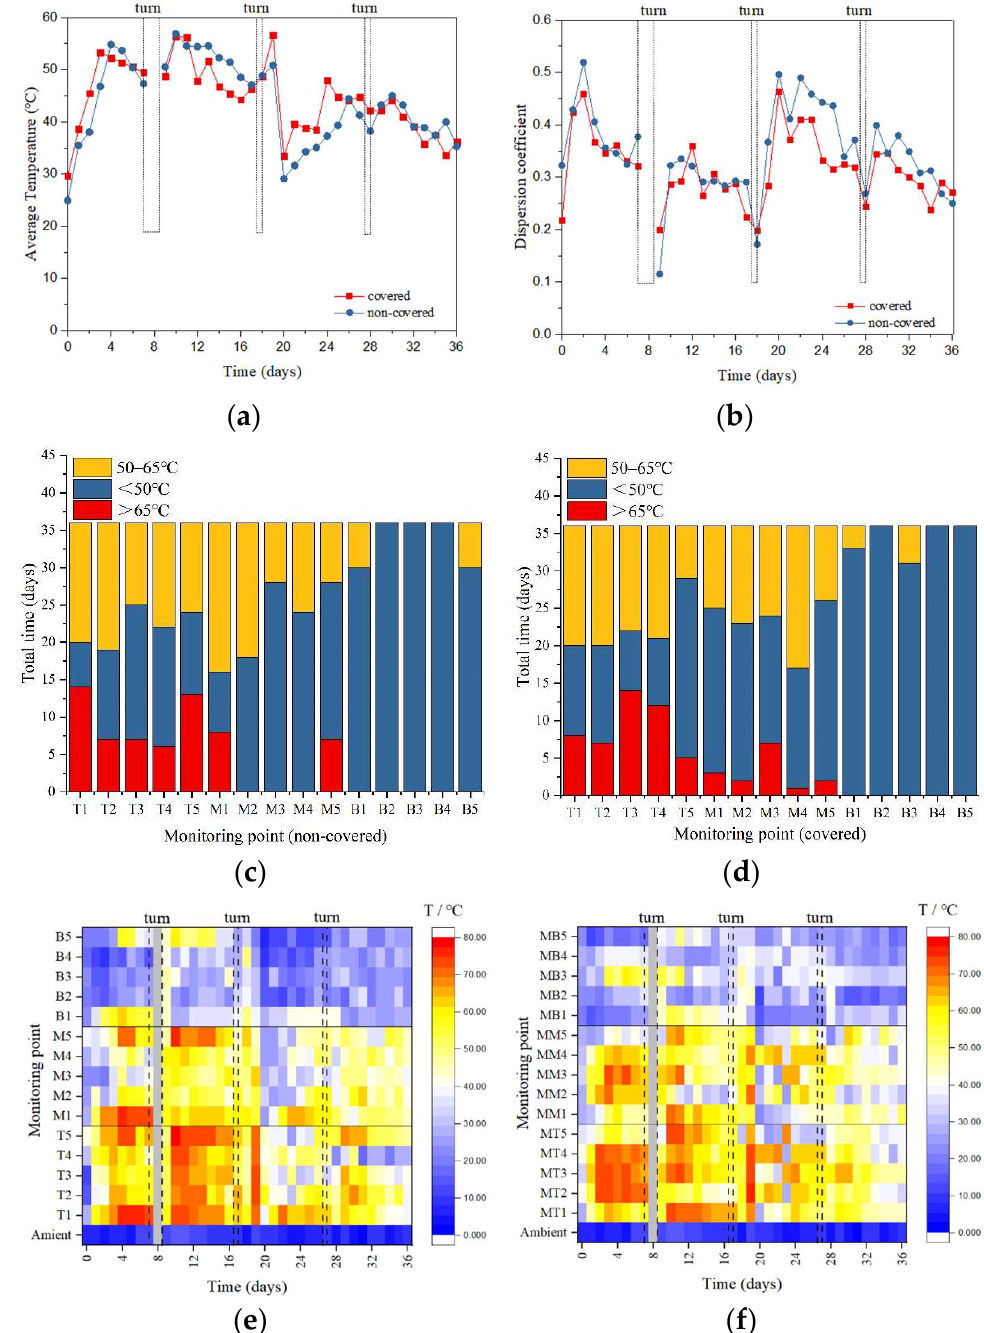
Figure 2. Average temperature ( a ) and dispersion coefficient of temperature ( b ) during aerobic composting; proportion of total time in different temperature ranges at different monitoring points in the non-covered group ( c ) and the covered group ( d ); temperature spatial distribution in the non-covered group ( e ) and the covered group ( f ). B1–5, the five monitoring points at the bottom of the pile in the non-covered group; M1–5, the five monitoring points in the middle of the pile in the non-covered group; T, the five monitoring points at the top of the pile in the non-covered group; MB1–5, the five monitoring points at the bottom of the pile in the covered group; MM1–5, the five monitoring points in the middle of the pile in the covered group; MT, the five monitoring points at the top of the pile in the covered group.